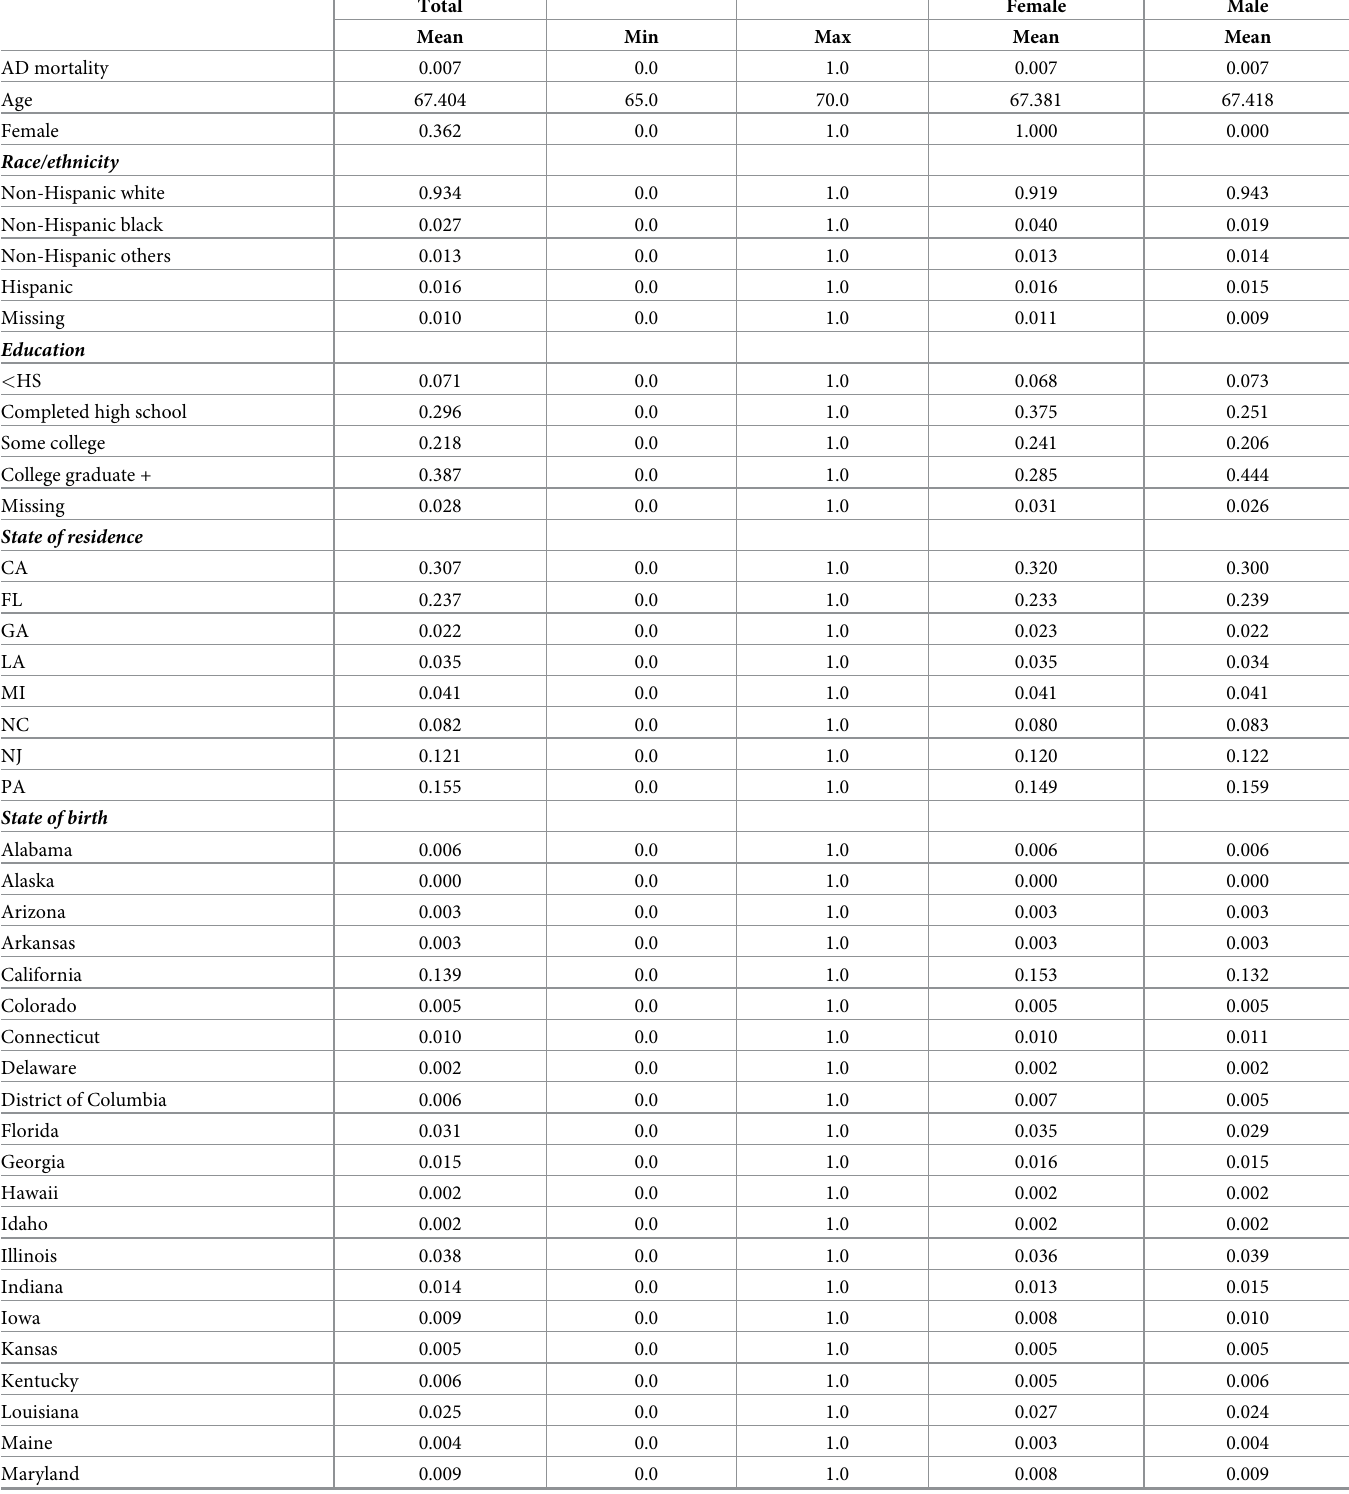
Table 1. Descriptive statistics (N =